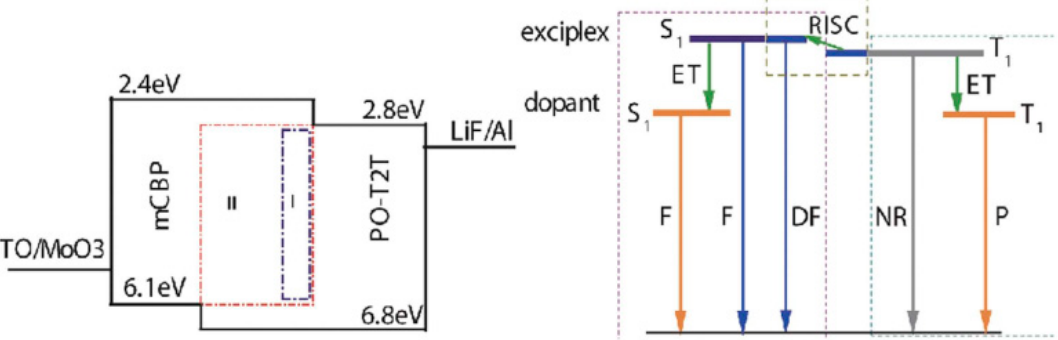
Figure 4. Device architecture of the WOLEDs and the incomplete energy transfer from blue exciplex to orange phosphor/ fl uorophor. Left: I and II indicate the dope areas of orange dopant, corresponding to WOLED with two EMLs and one EML. Right: incomplete energy transfer from exciplex to orange phosphor/ fl uorophor. F, DF, ET, NR and P denote fl uorescence, delayed fl uorescence, the part of triplet/singlet exciplex transfer its energy to the orange dopant, non-radiative process and phosphorescence, respectively [170].